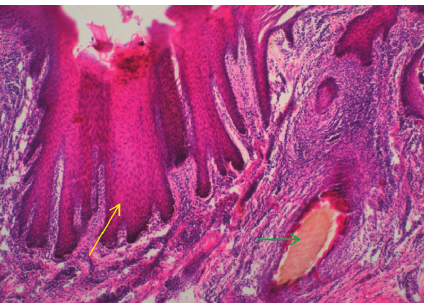
Figure 10: Opuntia stricta thorn (green arrow) deep in the ear muscles surrounded by mononuclear cells and granulation tissue. Elongated and expanded rete pegs (yellow arrow) and disrupted stratum corneum in severe chronic otitis externa (H&E x10).